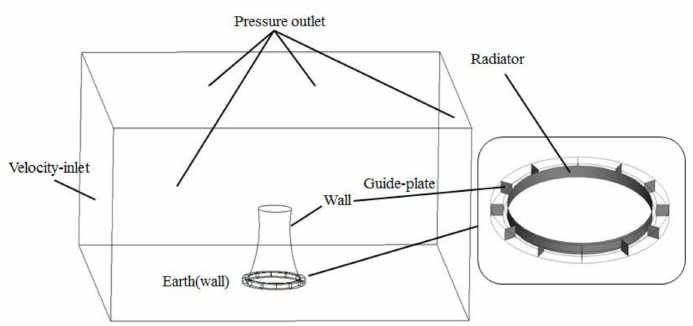
Figure 8. Computational domain and air flow boundaries.